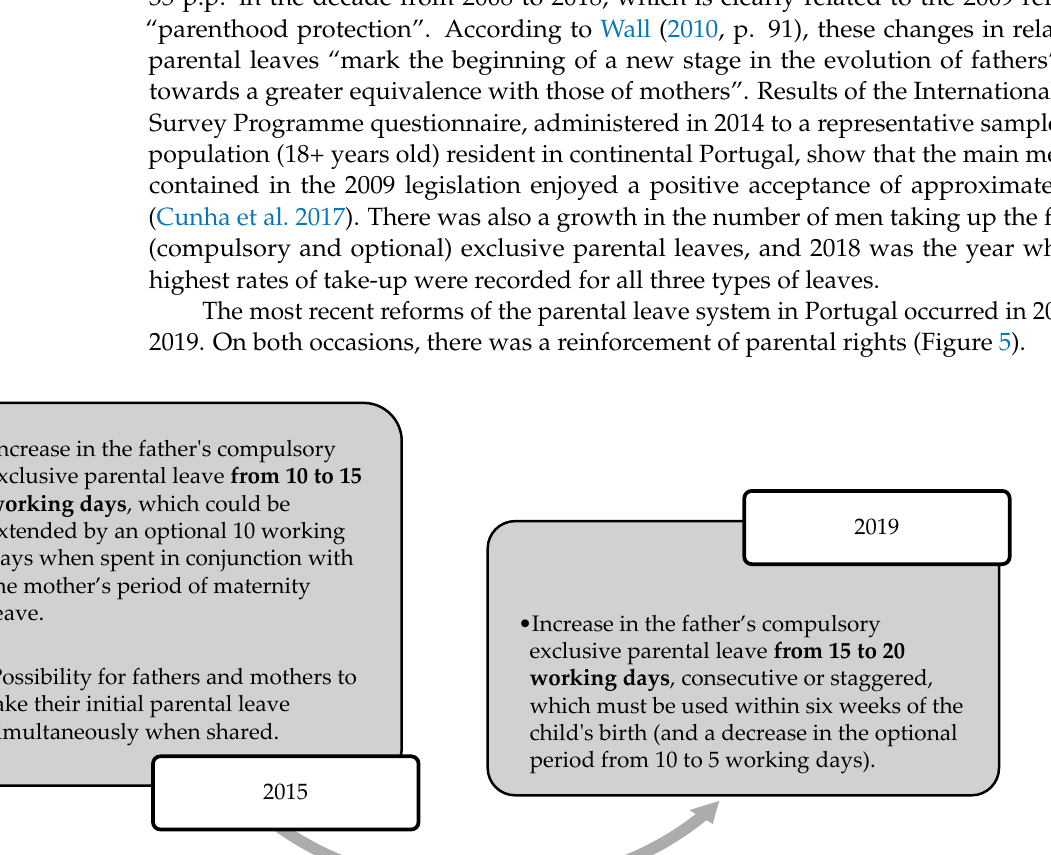
Figure 4. Evolution in father’s use of parental leave (percentage of number of births). Sources: CITE (2019); own calculations from Correia and Cunha (2020), Leitão et al. (2019), Wall et al. (2011, 2012, 2013), Wall, Leitão, et al. (2016) . Notes: Data for shared leave are aggregated with the father’s compulsory exclusive parental leave of five working days for the years 2000, 2001 and 2002 (only disaggregated from 2003 onwards [inclusive]) and exclude cases of shared leaves due to the mother’s death or physical or mental disability. From 2010 onwards, data exclude shared leaves of less than 30 days, or 15 consec- utive days, i.e., those that did not benefit from the bonus.